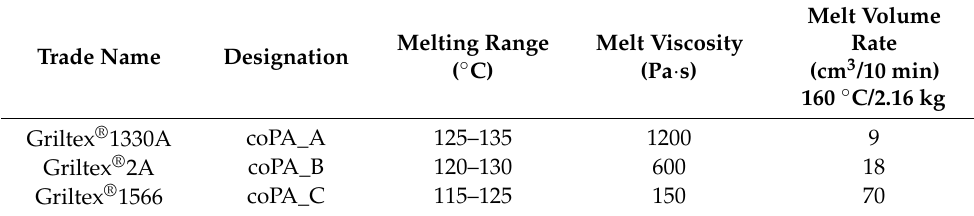
Table 1. Properties of copolyamides used as a polymer